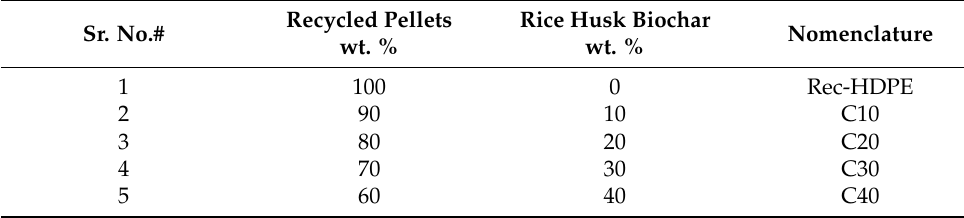
Table 1. Nomenclature of the samples. Sr. No.#